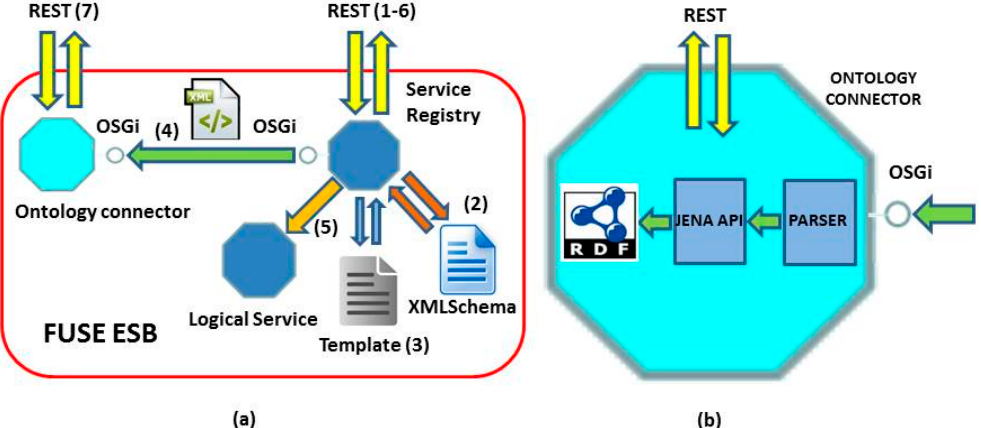
Figure 2. ( a ) Overall layout; ( b ) Ontology connector.